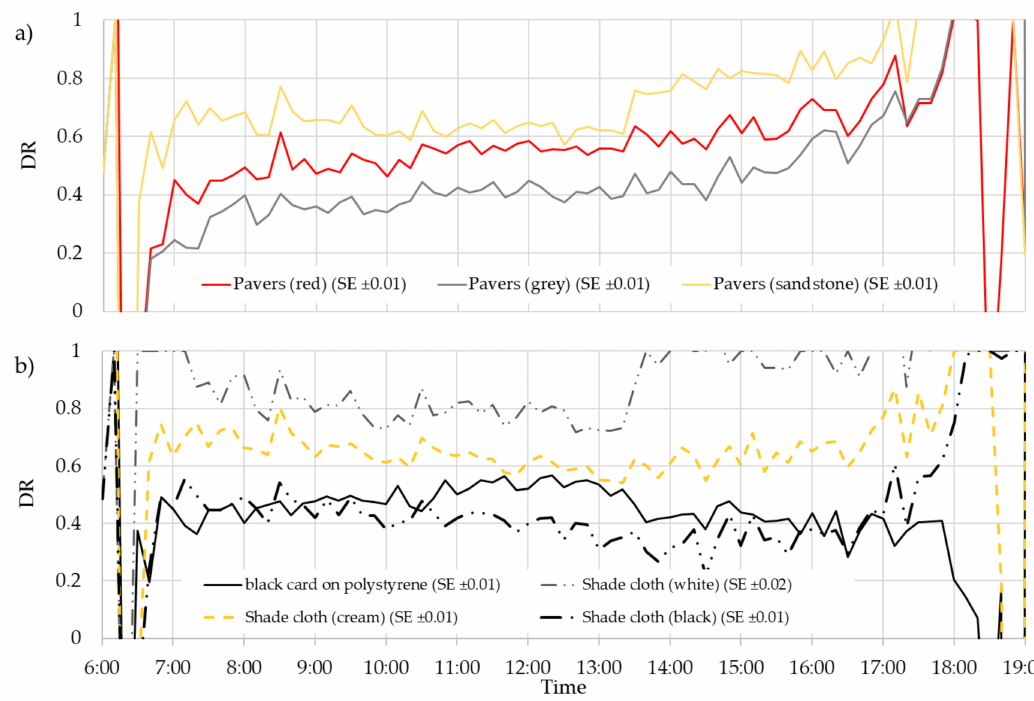
Figure 9. Daytime ratio (T iB,LE –T amb ) over (T iB,WPP –T amb ) for LEs, summer 2018. Comparison of: ( a ) di ff erent coloured pavers; and ( b ) low thermal inertia LEs. Data from 09:00 to 15:40 were averaged. Standard errors (SE) were calculated assuming random errors and a normal distribution [51].